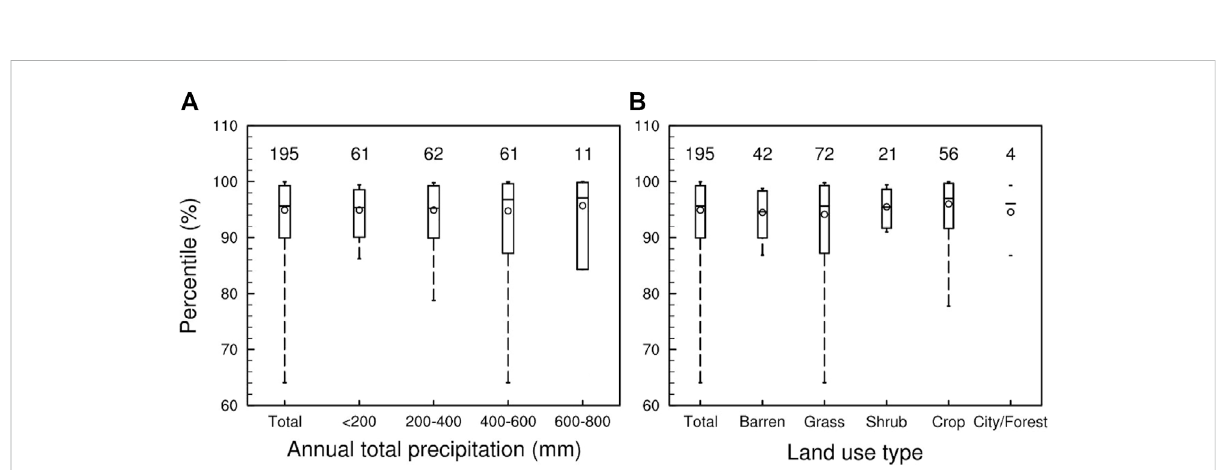
FIGURE 4 BoxplotsofmeanPmw(%)underdifferentlevelsofannualtotalprecipitation (A) ,mmandlandusetypes (B) .Fivefactorsofeachboxfromtopto bottom are the maximum, 90th percentile, median, 10th percentile and minimum values. The mean value is marked by a small circle, and the numbers listed above the boxes are the number of stations which experienced local-source sandstorms in 1954 –